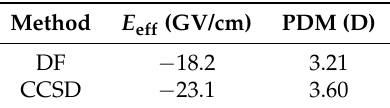
Table 1. Summary of the calculated linear expectation value approximation (LECC) results in YbF using a quadruple zeta (QZ)